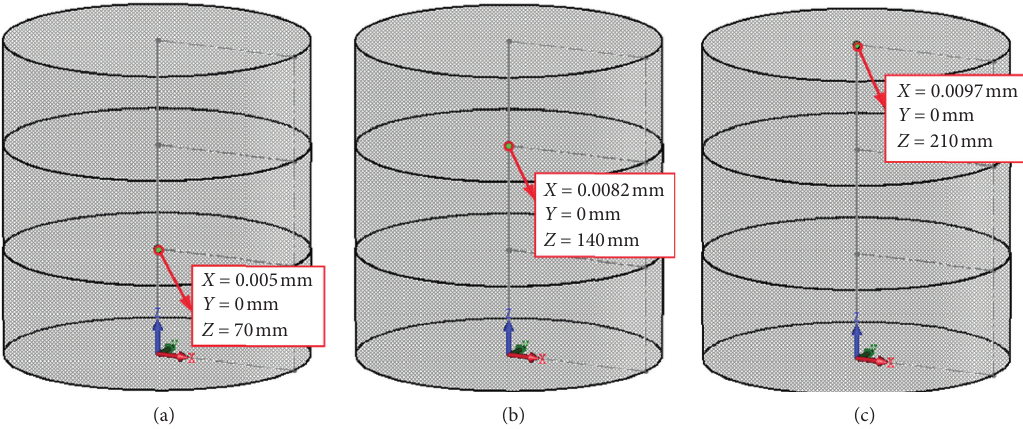
Figure 4: The centroid coordinates of the top surface of the assembled 3-stage rotor are measured by software. (a) The 1st rotor. (b) The 2nd rotor. (c) The 3rd